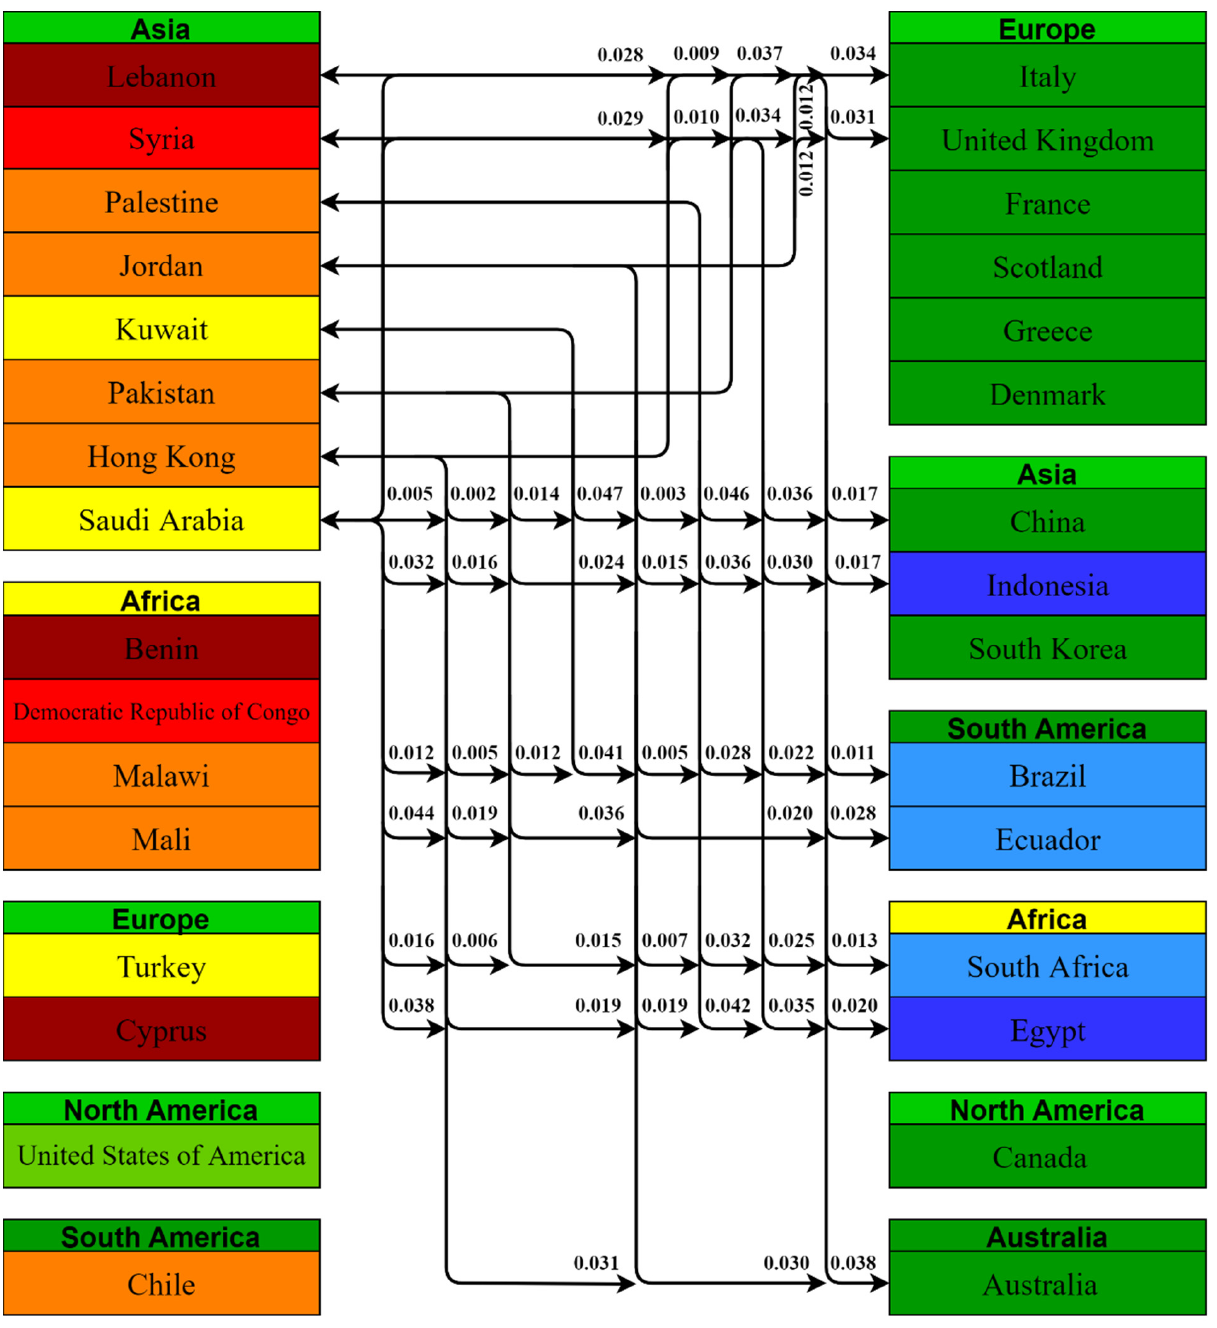
Figure 5. Pairwise comparison between Asian countries having lesser acceptance rates with the rest of the world and their p values.